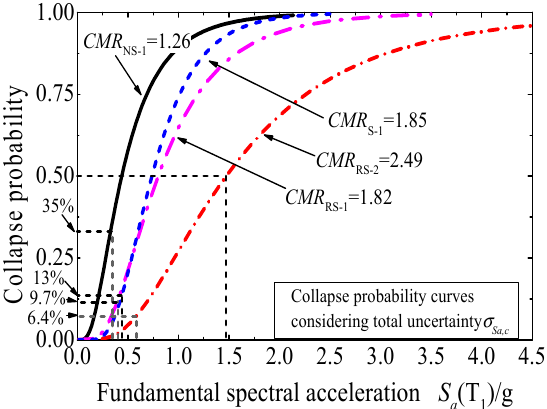
Figure 9. Collapse vulnerable curves with σ Sa,c .